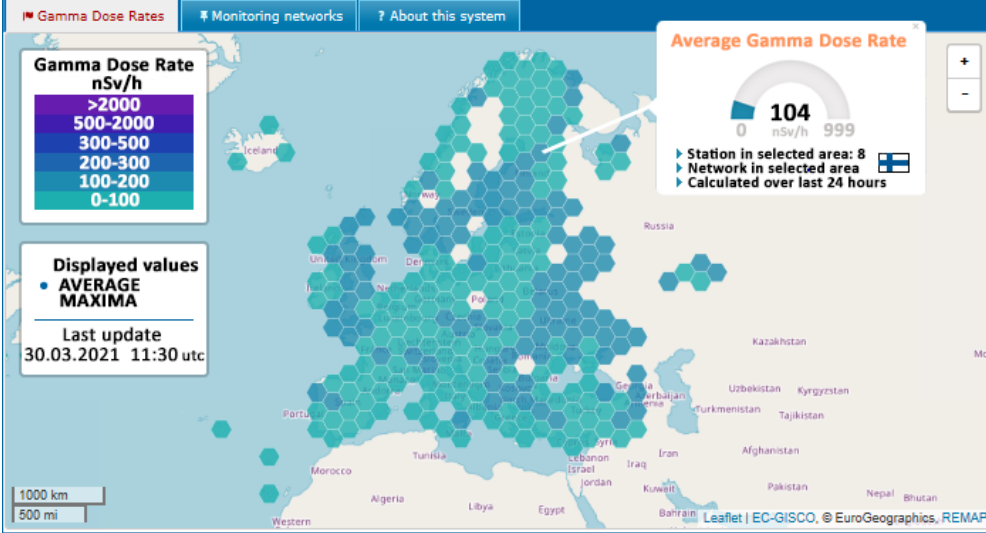
Figure 19. Link to EURDEP network measurements (gamma dose rates) from an EMERCON message.